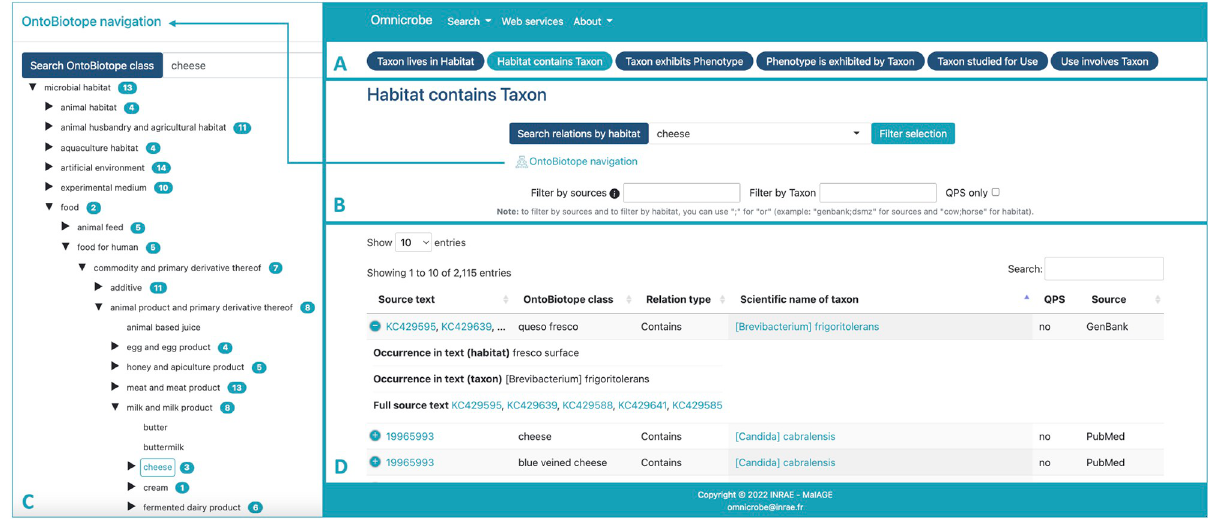
Fig 3. Omnicrobe web interface. Republished from http://omnicrobe.migale.inrae.fr under a CC BY license, with permission from INRAE MaIAGE, original copyright 2022.